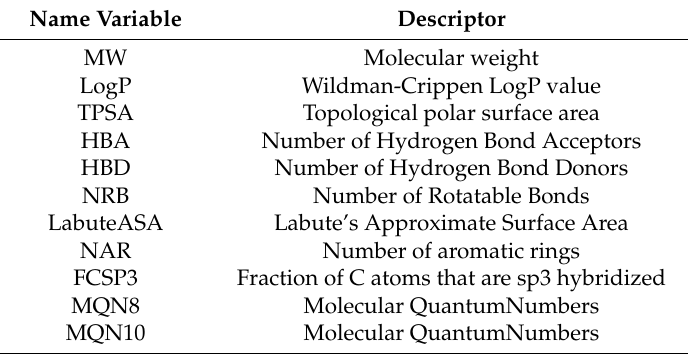
Table 4. Descriptors used for PCA.